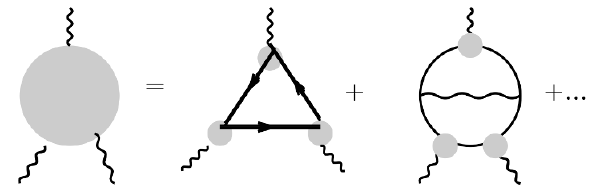
Figure 1 . The decomposition of h